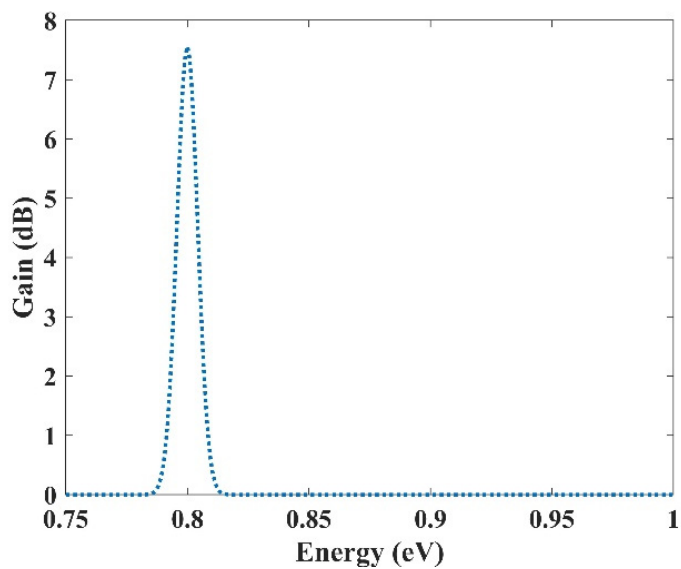
Figure 12. Selective amplification for channel 1 (1550 nm).